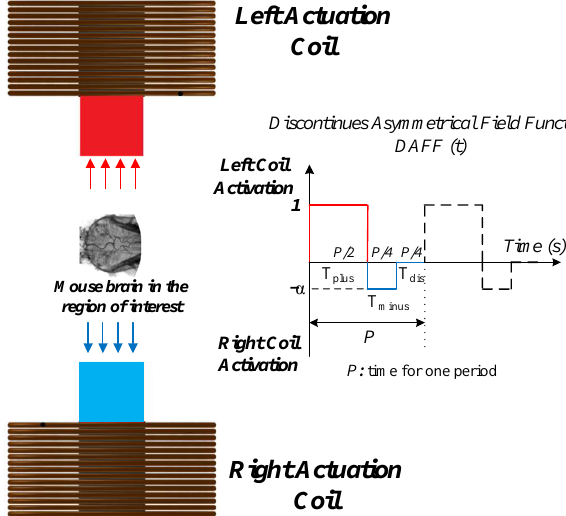
Figure 1. Schematic of the discontinuous magnetic actuation system for drug delivery and blood–brain barrier (BBB) passage using the proposed discontinuous asymmetrical field function (DAFF).